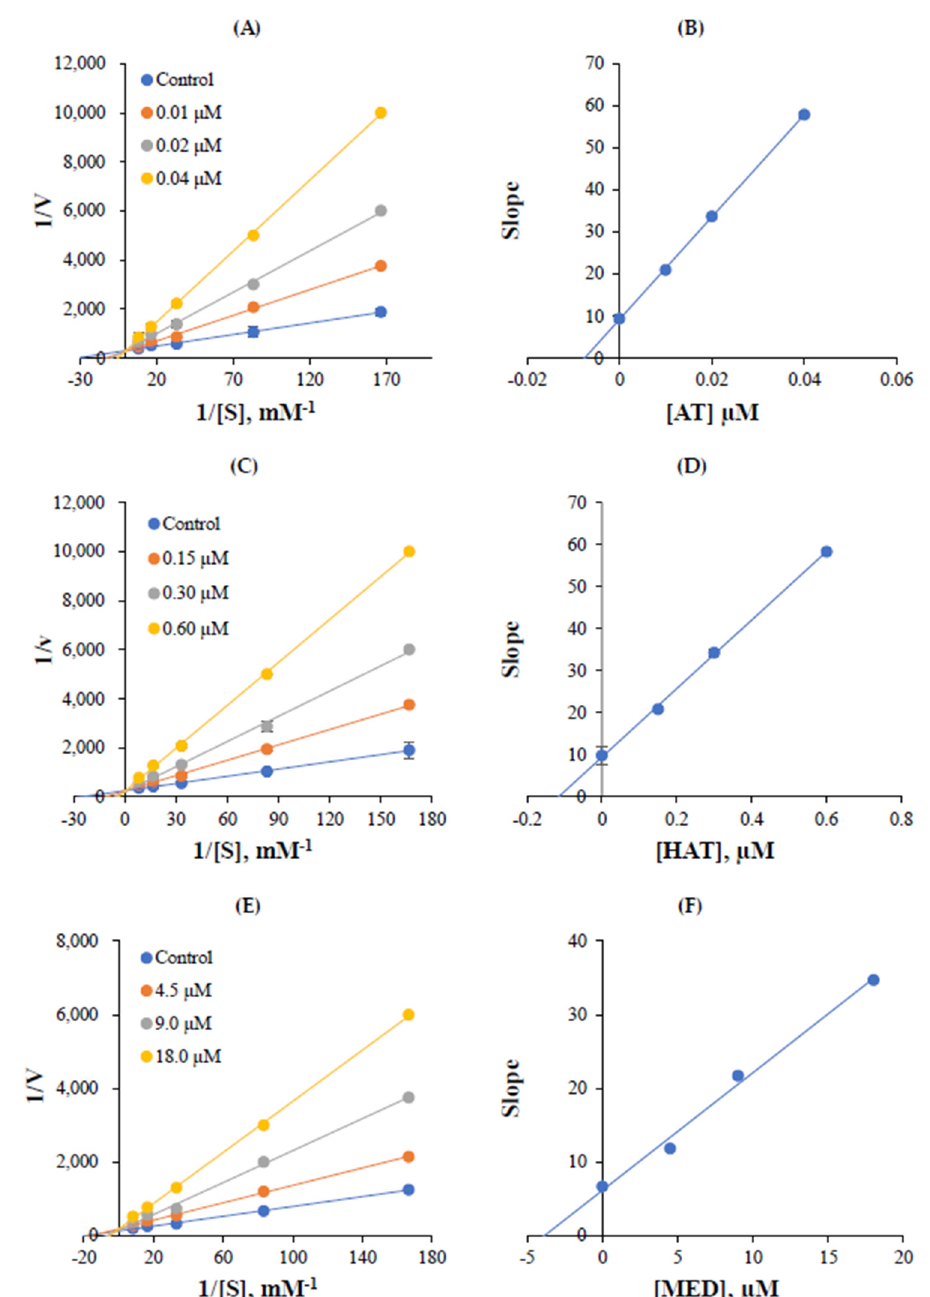
Figure 3. Lineweaver–Burk plots ( A , C , E ) for hMAO-A inhibition by AT, HAT, and MED, and their secondary plots ( B , D , F ) using their slopes following inhibitor concentrations. Five different substrate concentrations (0.006, 0.012, 0.03, 0.06, and 0.12 µM) were used, and inhibitors were added to make three concentrations, i.e., ~1/2 × IC 50 , ~IC 50 , and ~2 × IC 50 . Triplicate experiments determined error bars.